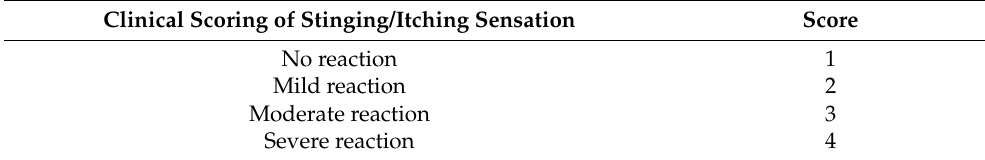
Table 1. Measurement of clinical stinging/itching after capsaicin application in a 4-point